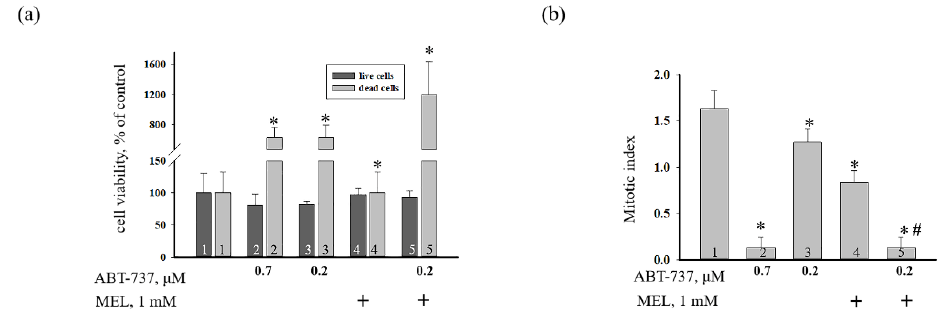
Figure 2. The e ff ect of MEL and ABT-737 on the viability and proliferation of HL-60 cells. Cells were treated with 0.7 µ M ABT-737 (column 2), and 0.2 µ M ABT-737 (columns 3) and 1 mM MEL (column 4), and MEL in combination with 0.2 µ M ABT-737 (column 5); untreated cells (control, column 1). ( a ) Cell viability in % relative to the control. ( b ) Mitotic index was calculated in the presence of 0.7 µ M ABT-737 (column 2), and 0.2 µ M ABT-737 (columns 3) and 1 mM MEL (column 4), and MEL in combination with 0.2 µ M ABT-737 (column 5); untreated cells (control, column 1). “ + ” means the presence of MEL. The data are presented as the means ± S.D. of six separate experiments. * p < 0.05 significant di ff erence in values in comparison with the control, # p < 0.05 significant di ff erence in values compared to the value obtained after the addition of ABT-737 alone (0.2 µ M, column